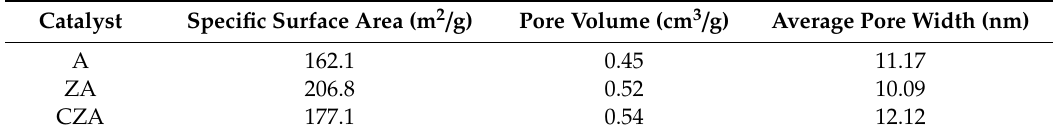
Table 1. Specific surface area, pore volume and aperture of the